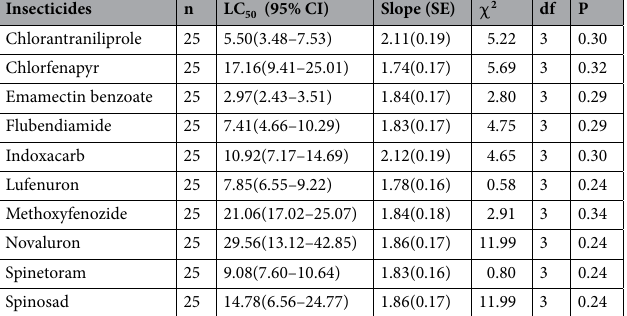
Table 2. Toxicity of selected insecticides against S. litura after 96 h. n number of observations used for Probit analysis,